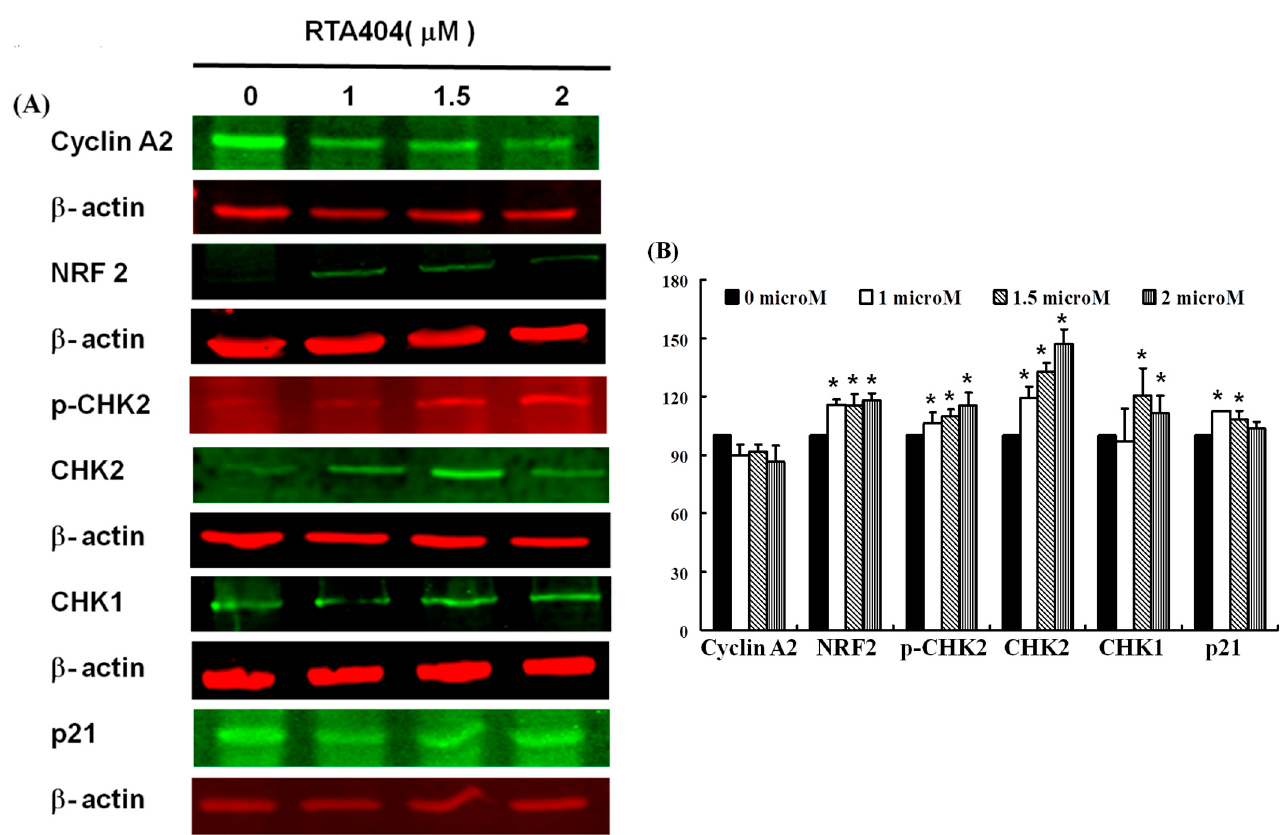
Figure 6. ( A ) RTA404 regulated DNA damage checkpoint kinase expression in CHK1, CHK2, and p-CHK2, as well as cyclin A2, NRF2 and p21 gene expression in the U87MG cells. Cells were treated with RTA404 (0, 1, 1.5, and 2 μ M) for 24 h. Gene and protein expression was subsequently detected through Western blotting. ( B ) Results are expressed as a percentage of the control, with the control being 100%. All data are reported as means ± standard errors of the mean on the basis of the results of at least three separate experiments. Statistical analysis was performed using the t test, with differences between the treatment and control groups considered significant at p < 0.05, as denoted by *.